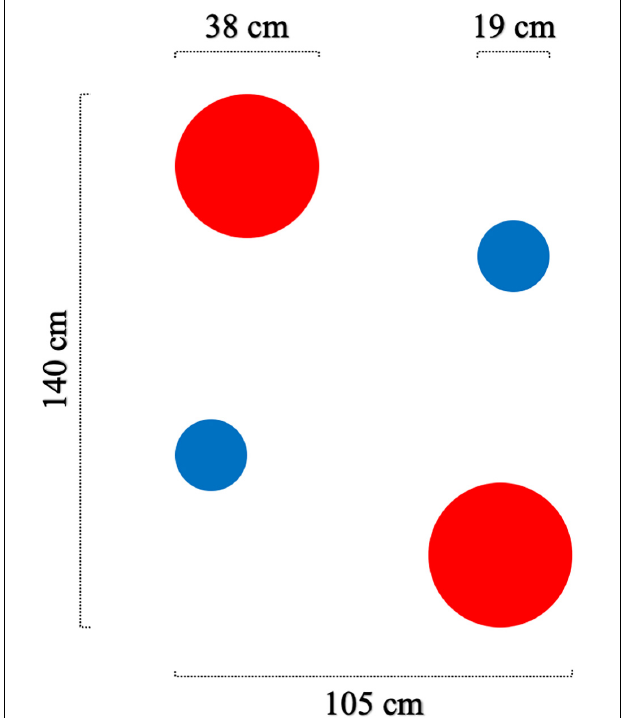
FIGURE 2 | Target arrangement for task